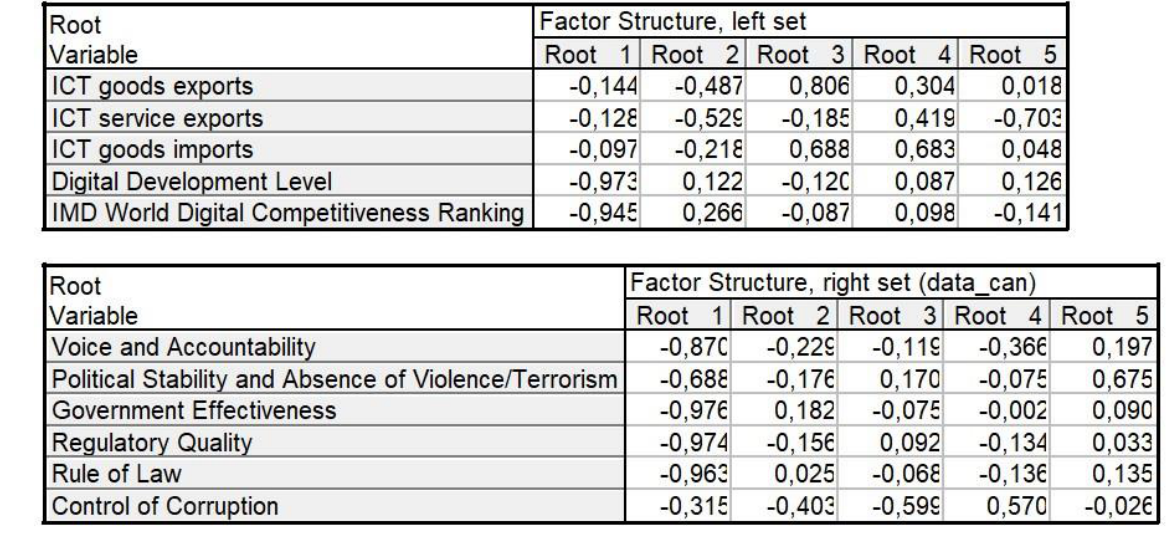
Figure 4. Factor Structures